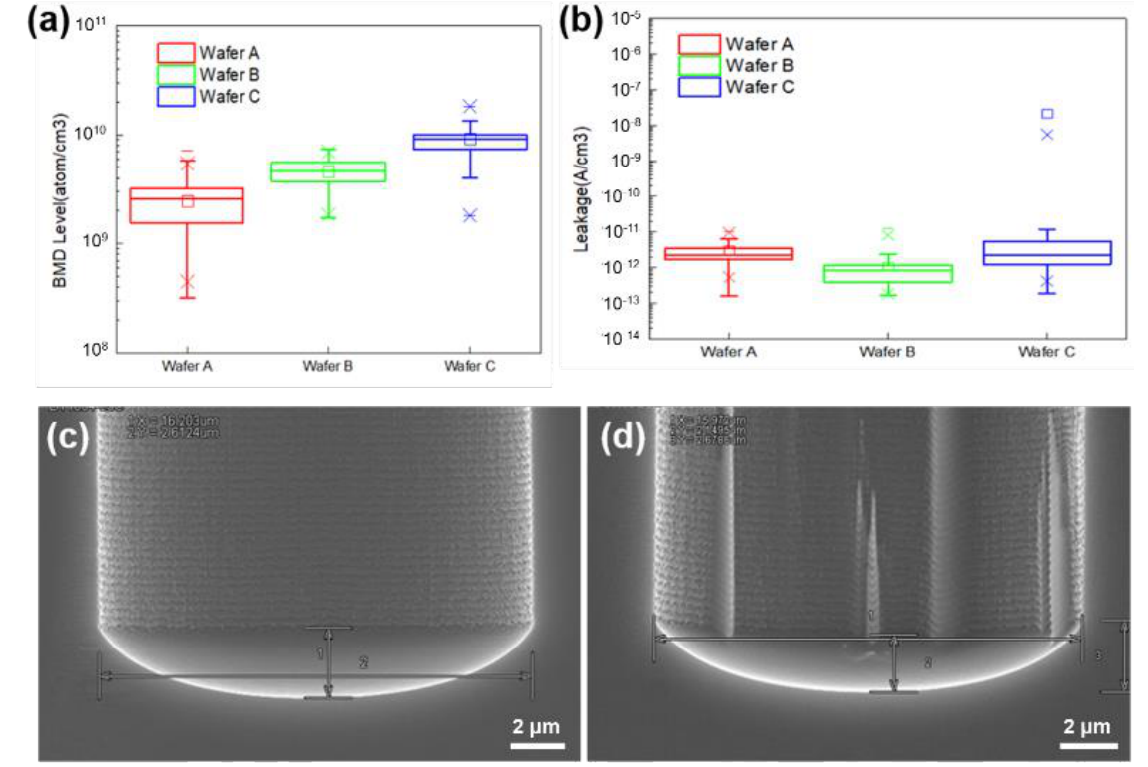
Figure 7. ( a ) BMD density of the three substrate types used in this work. ( b ) Leakage performance of the TSV structures fabricated on the three different wafers. ( c ) TSV profile in wafer A with low BMD. ( d ) TSV profile in wafer C with high BMD.